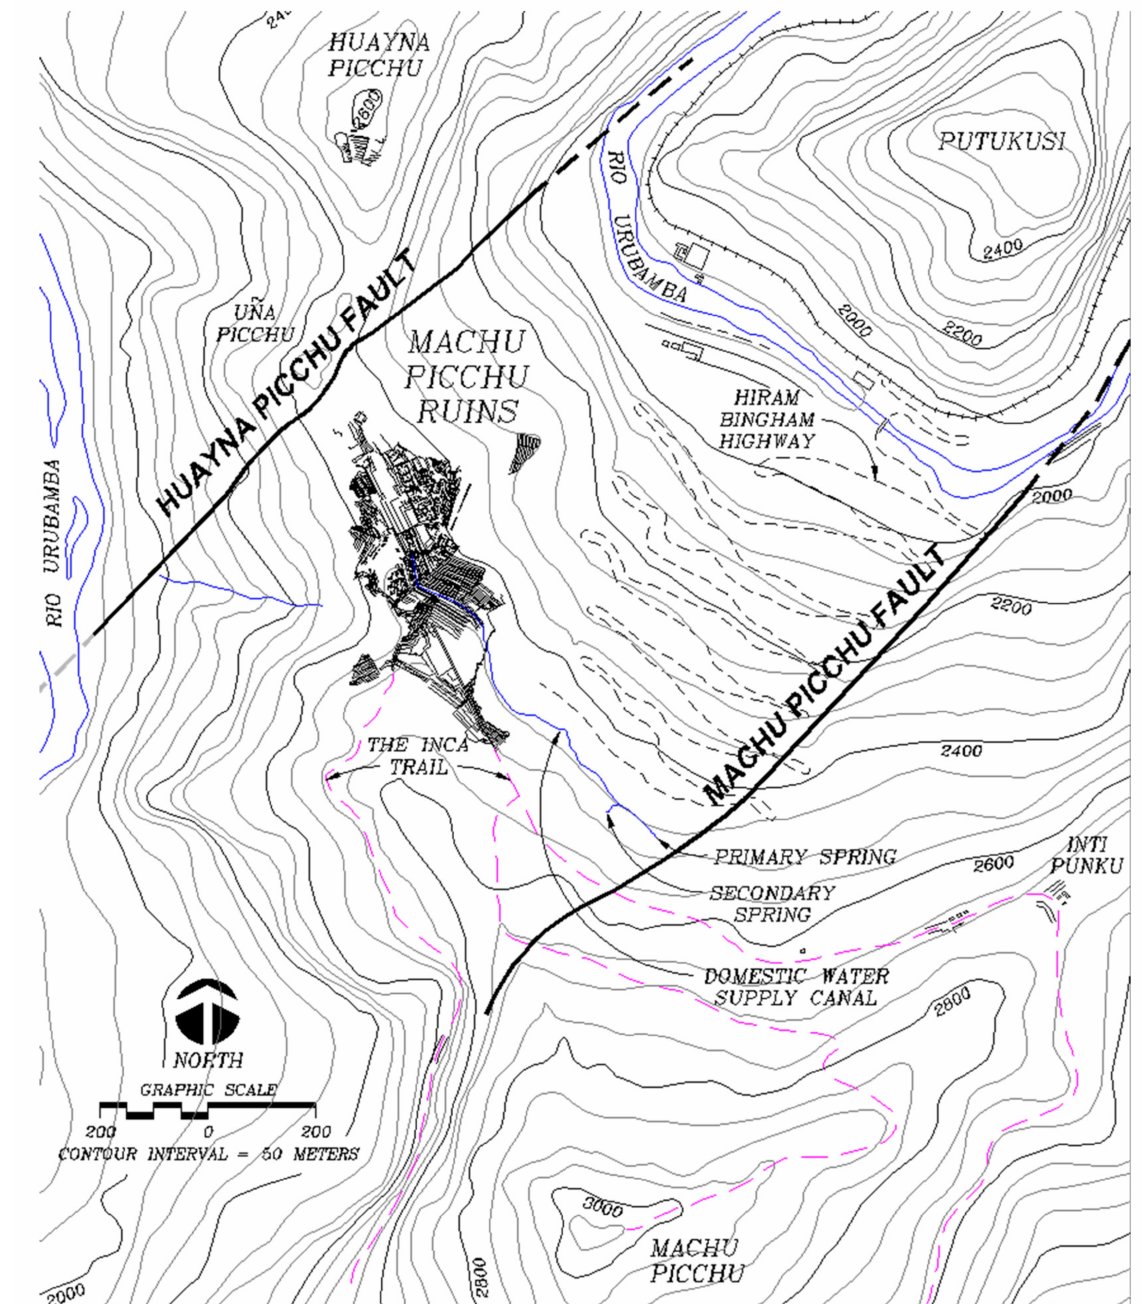
Figure 2. Machu Picchu lies between two faults. (Reproduced from Machu Picchu: A Civil Engineering Marvel [5], with permission from ASCE, the